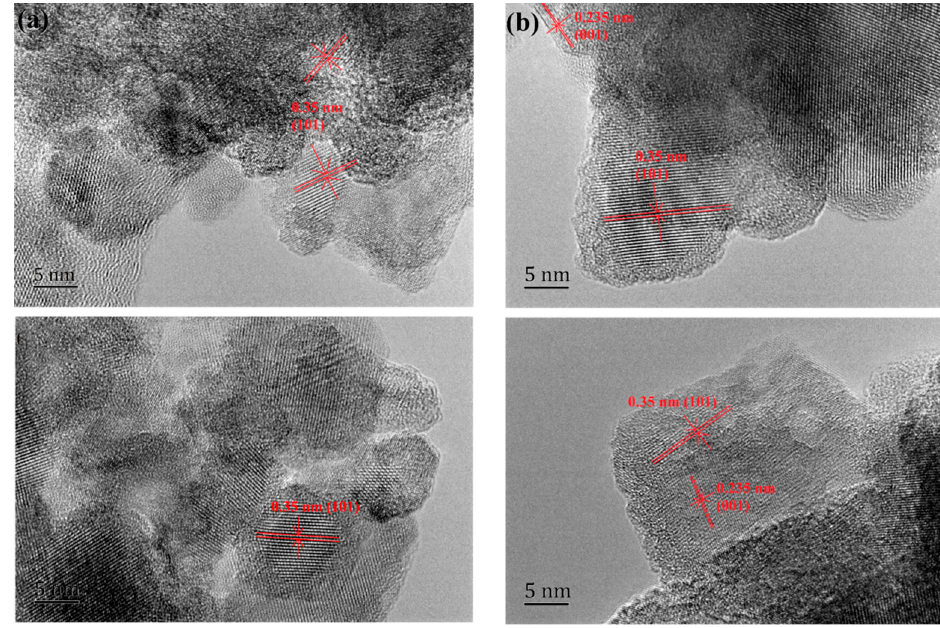
Figure 26. HR-TEM images of TiO 2 -0F ( a ), TiO 2 -10F ( b ) [99].